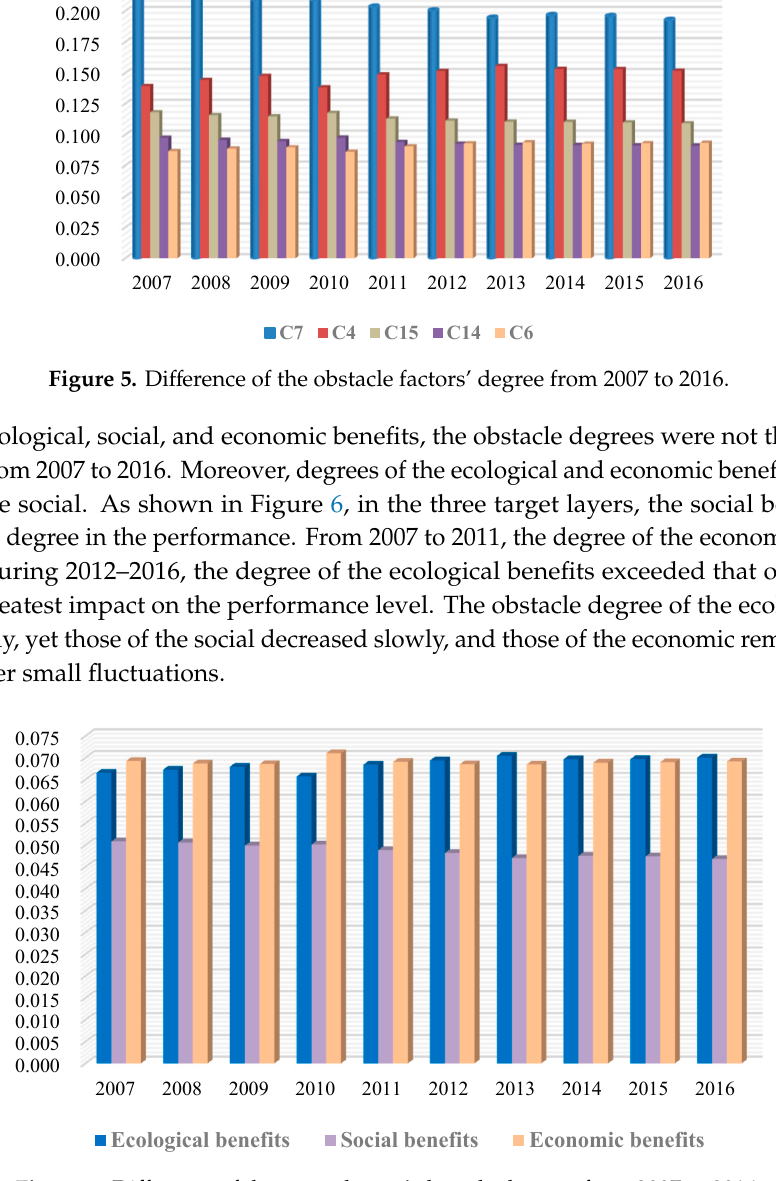
Figure 6. Di ff erence of the target layers’ obstacle degrees from 2007 to Figure 6. Difference of the target layers’ obstacle degrees from 2007 to 2016.